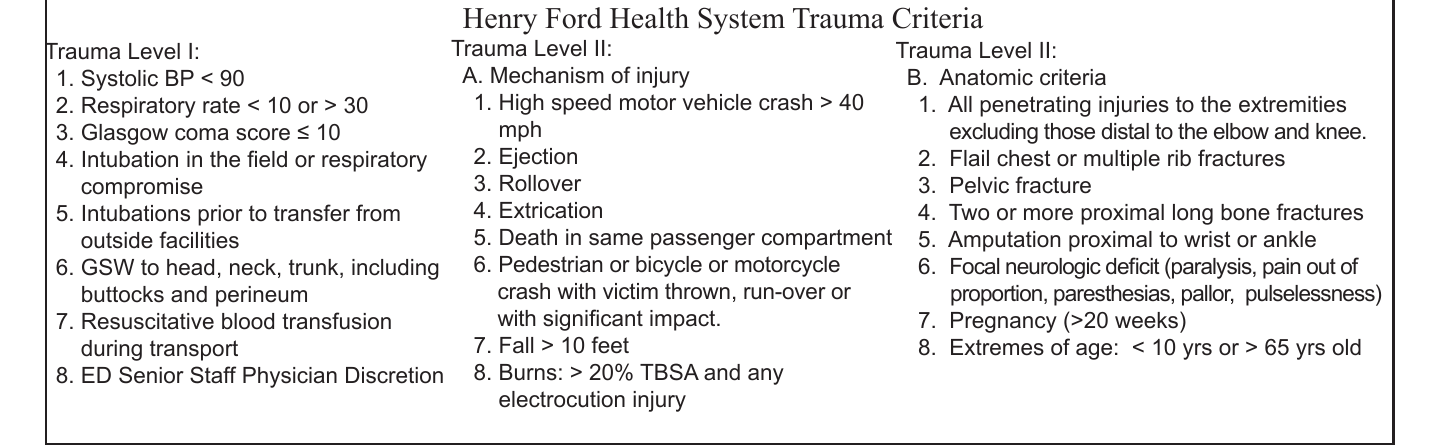
Figure 1 . Trauma